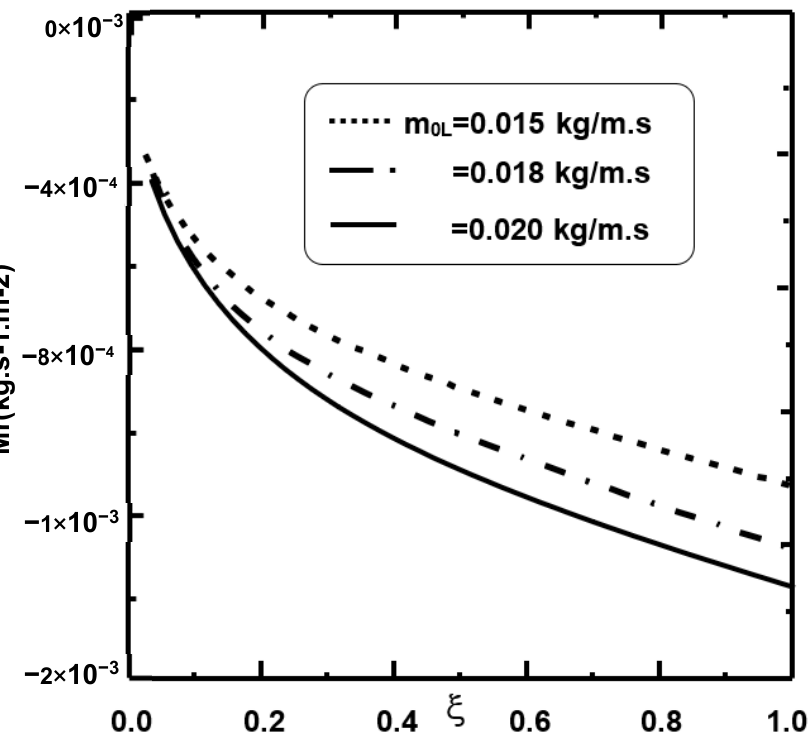
Figure 12. Effect of inlet liquid mass flow on the cumulated condensation rate: T 0 = 293.15 K, T 0L = 293.15 K, T w = 293.15 K, Φ 0 = 0.03, c 0 = 0.3, q 1 = − 1000 W/m 2 , u 0 = 1 m/s, H = 1 m, d = 0.015 m, p 0 = 1 atm.